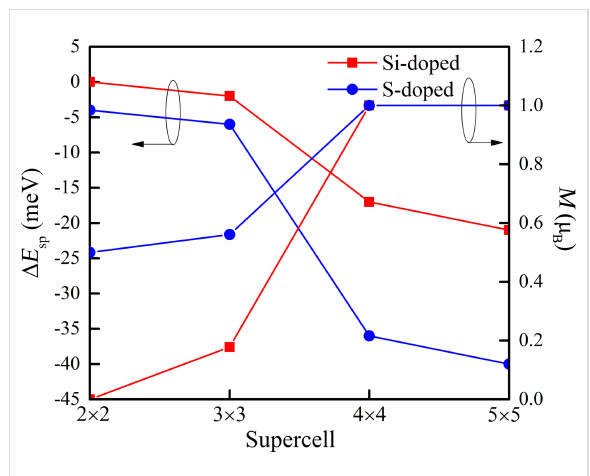
Figure 3: Energy differences Δ E sp and net magnetic moments M as functions of the in-plane size of